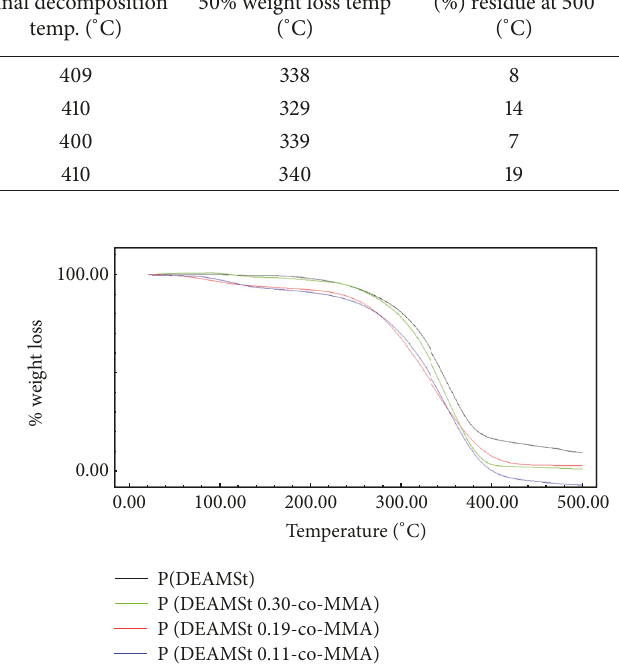
BCG (0.035 g) in 500 mL water. Then, in the dye adsorption experiments, 0.1 g of polymer samples was added onto 5